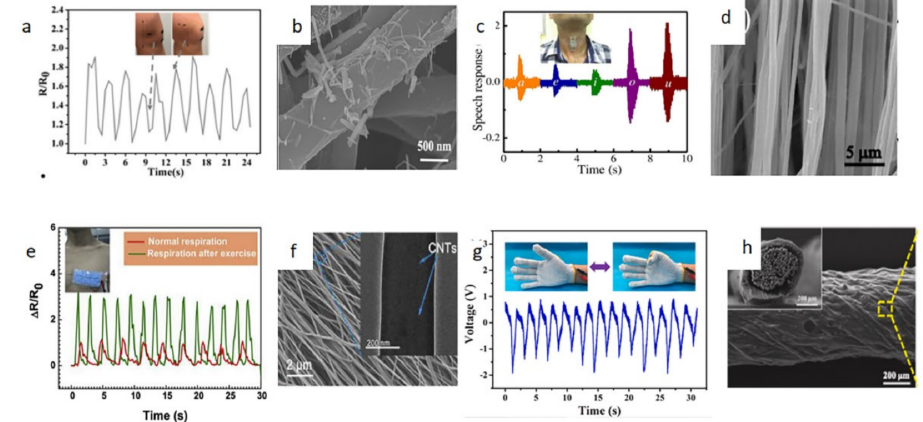
Figure 12. The response of the sensor in different parts and the SEM image of the fiber membrane. ( a , b ) knee bends [57]; ( c , d ) swallow [58]; ( e , f ) heart beats [59]; ( g , h ) Finger bends